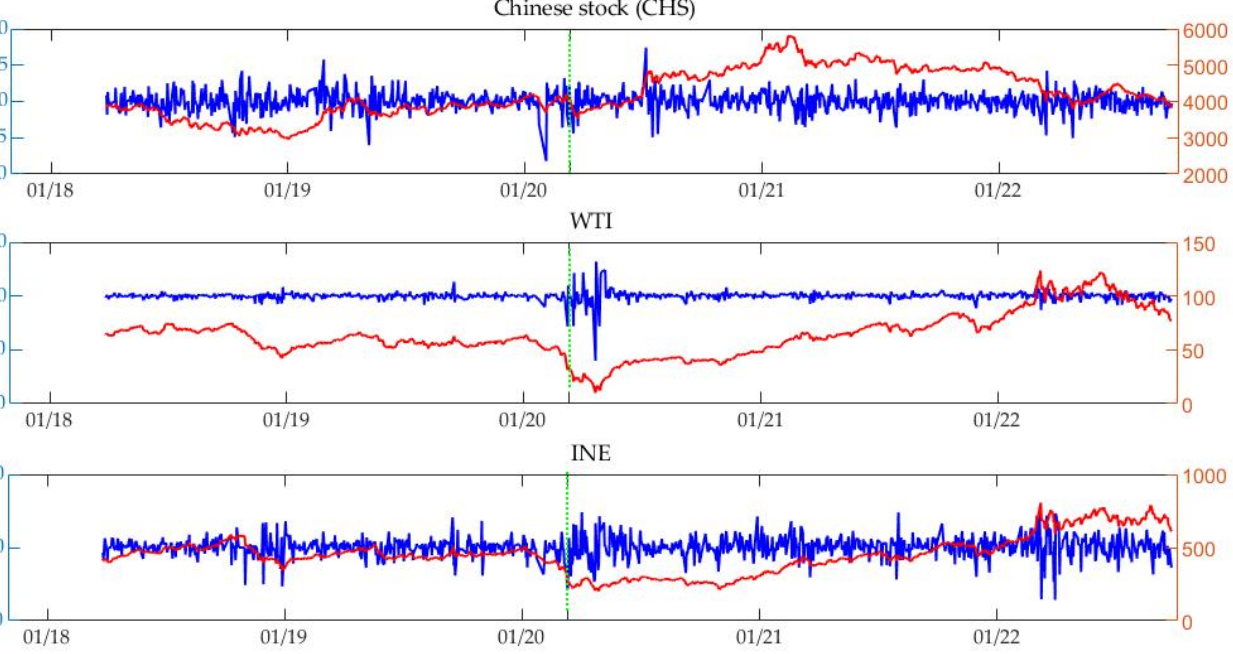
Figure 1. Daily price and log returns. (Notes: Red lines depict daily prices while blue lines depict daily log returns).